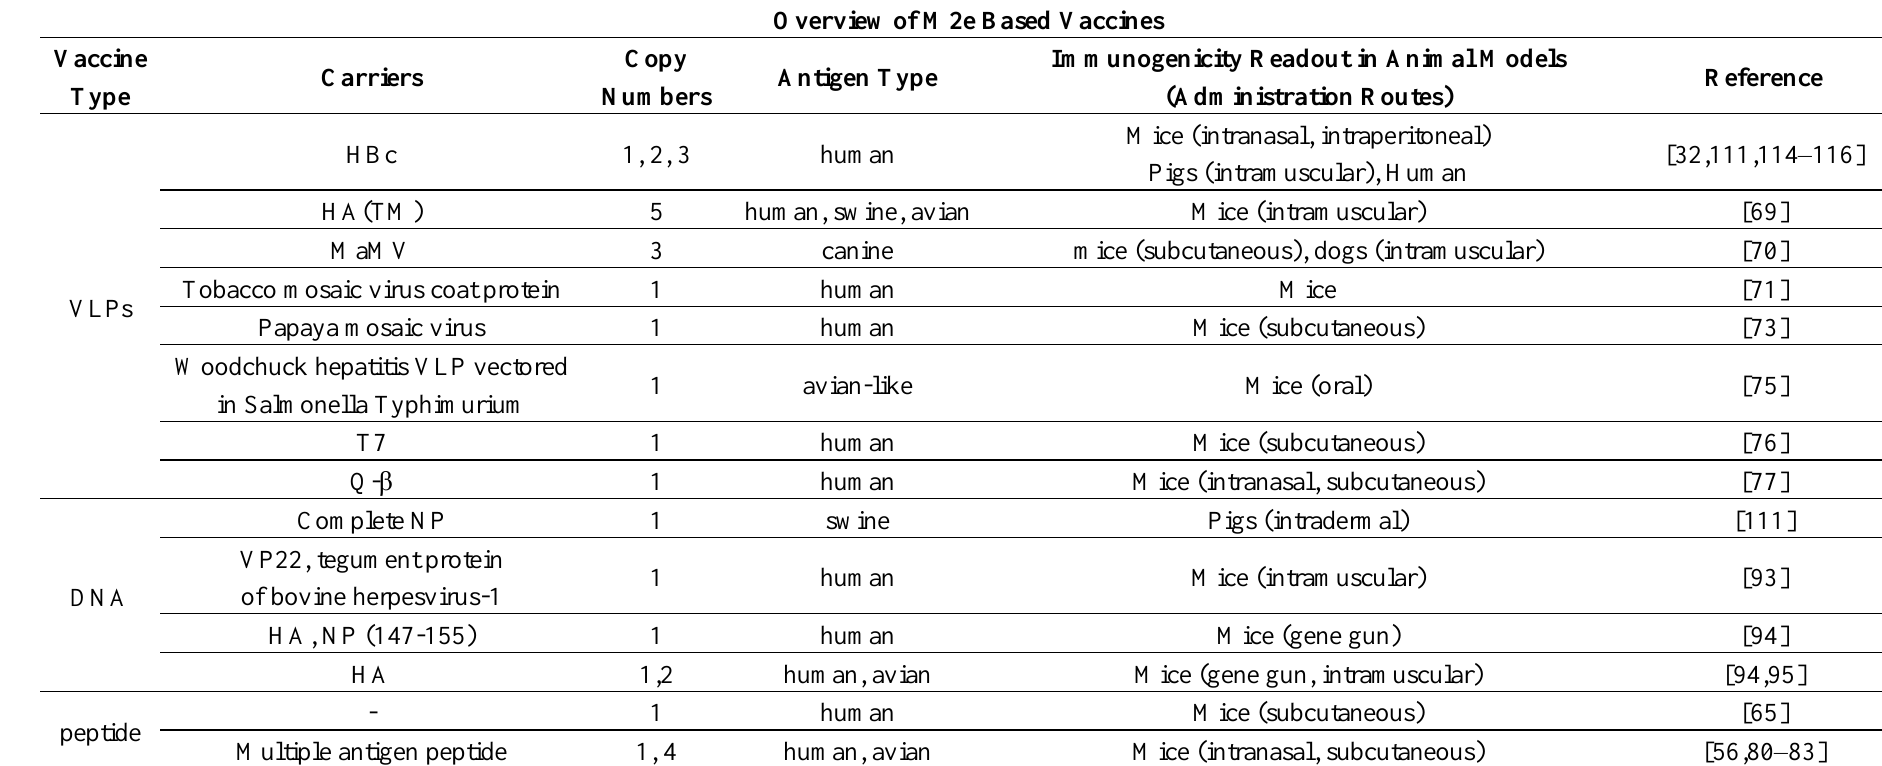
Table 1. Overview of M2e based